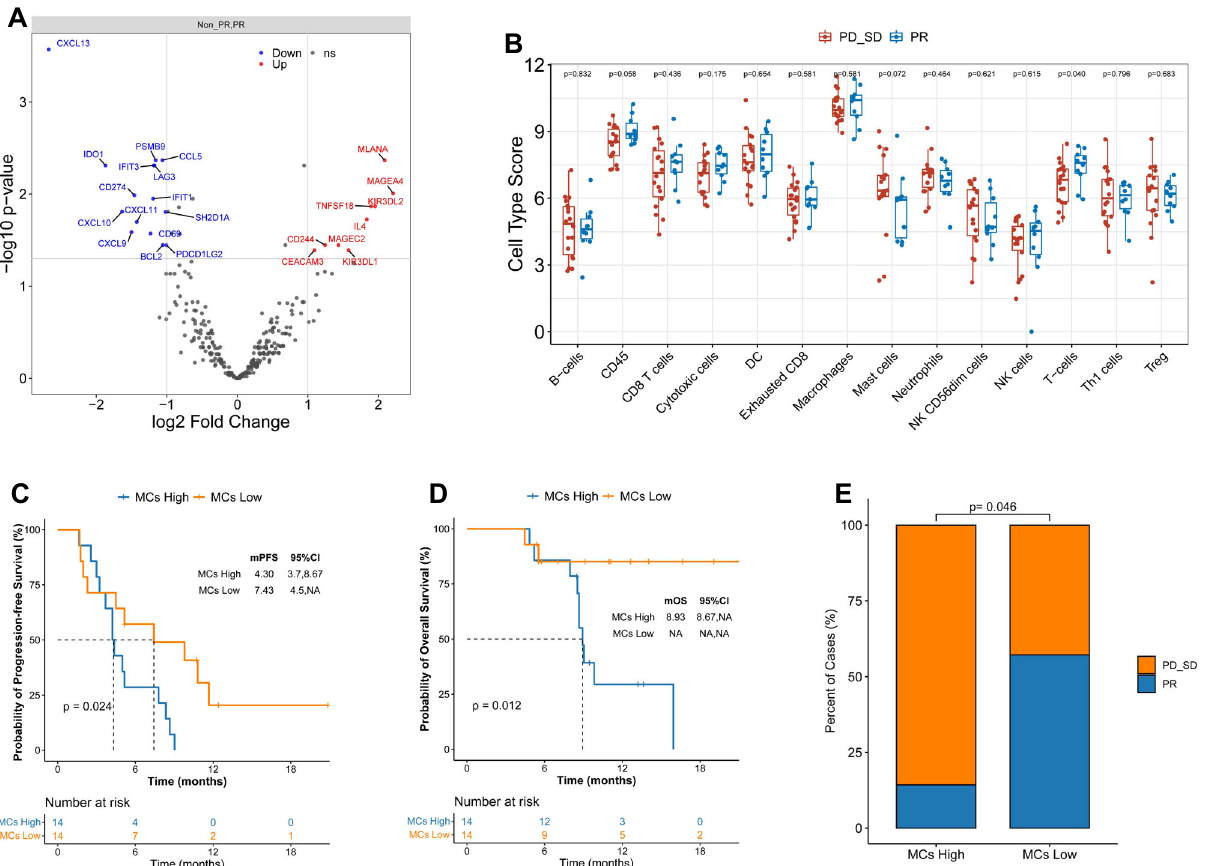
Fig. 4 | Identi fi cationofdifferentially expressed genesand immune cell pro fi le analyses in responders and non-responders. A Transcriptome analysis on dif- ferential expression between responders ( n =10) and non-responders ( n =18), DESeq2 was provided to perform differential expression testing using the Wald test, multiple testing was adjusted using Benjamini and Hochberg method. B The abundance of prede fi ned 14 immune cells composition between responders ( n =10) and non-responders ( n =18), box plots are indicated in terms of minima, maxima, centre, bounds of box and whiskers (interquartile range value), and per- centile in the style of Tukey. Wilcoxon test was used to determine the statistical